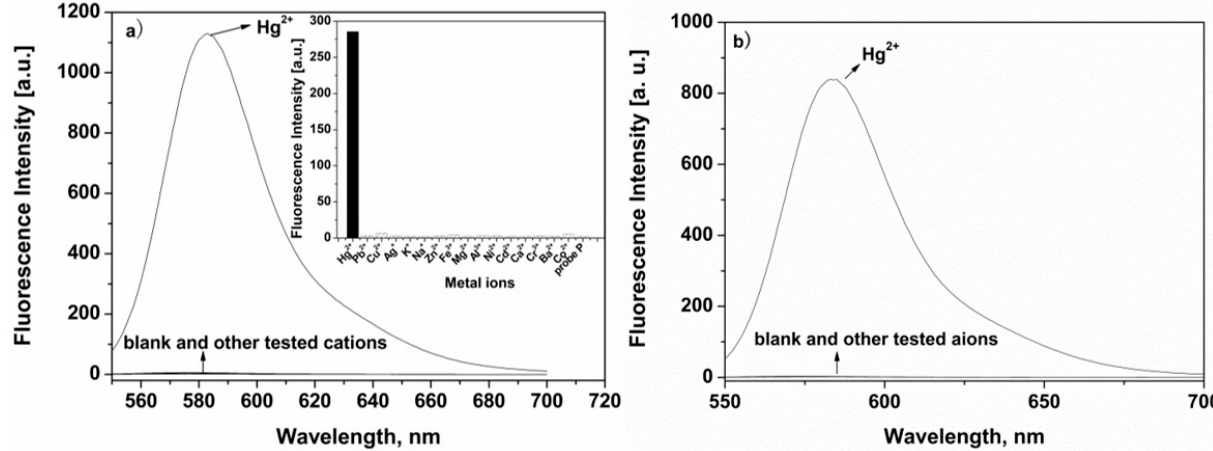
Figure 2. ( a ) Fluorescence spectra of P (5 µ M) with different cations (50 µ M) in the aqueous media (ethanol-water, 8:2, v / v , 20 mM HEPES, pH 7.0). Inset: The fluorescence intensity at 583 nm of P (5 µ M) in the presence of different metal ions (Hg 2+ is 10 µ M and K + , Na + , Ag + , Ca 2+ , Mg 2+ , Zn 2+ , Pb 2+ , Cd 2+ , Ni 2+ , Co 2+ , Cu 2+ , Cr 3+ , and Fe 3+ are 100 µ M, respectively).